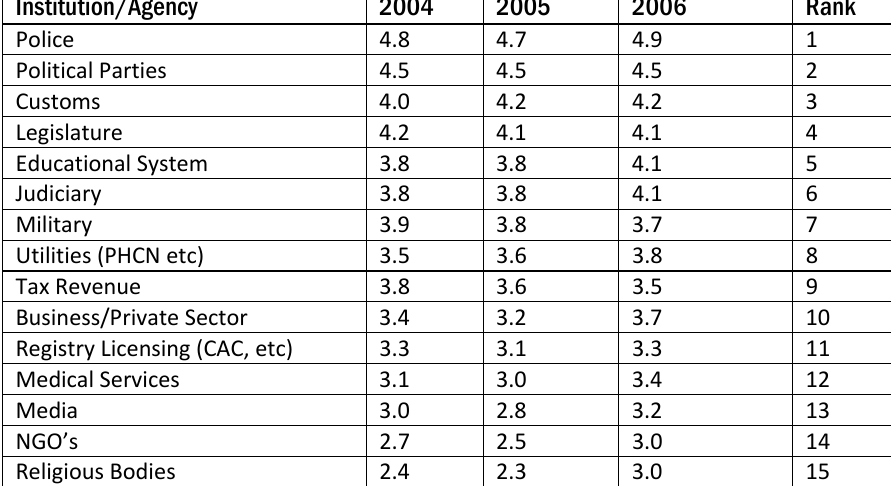
TABLE 4: Assessment of levels of corruption in Nigeria Institution (SCALE: 1-5) Institution/Agency